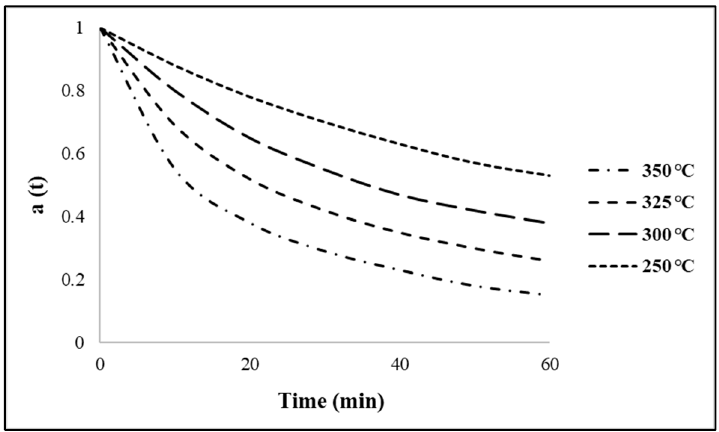
Figure 3. Activity parameter a(t) as a function of time at varying reaction temperatures with catalyst = Ni/ZrO 2 . Reaction conditions: pressure = 30 bar, H 2 /oil ratio = 1000 and inlet liquid flow = 0.1 mL/min.